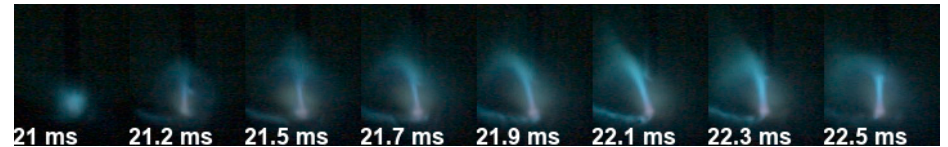
Figure 3. CMT ignition, time correlates with the waveforms in Figure 1.